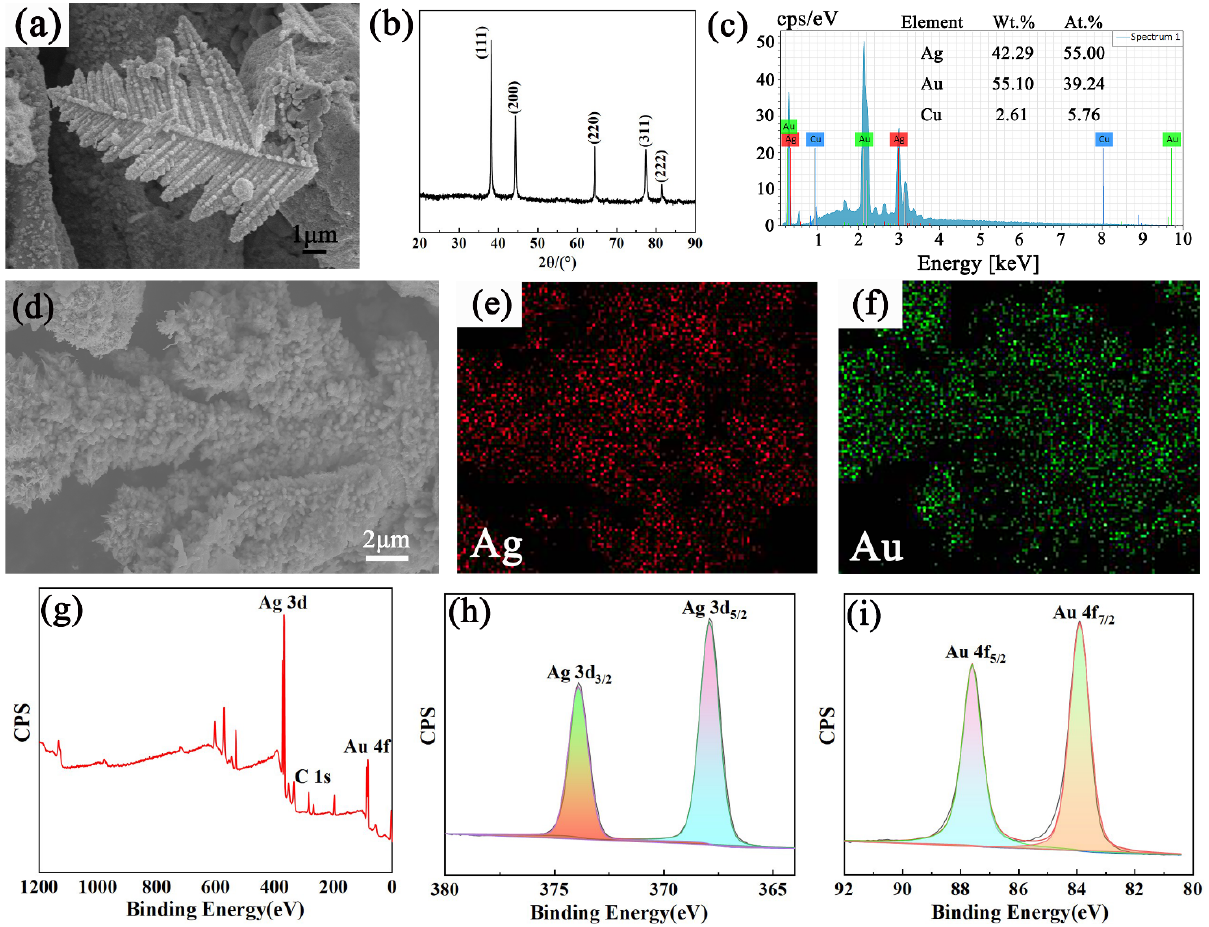
Figure 2. The dendritic Au–Ag structure was obtained by reaction with 3 mL chloroauric acid solution for 15 min. ( a ) SEM, ( b ) XRD, ( c ) EDS, ( d ) SEM, ( e , f ) EDS mapping, ( g ) XPS and ( h , i ) high-resolution XPS spectra for two different energy regions.